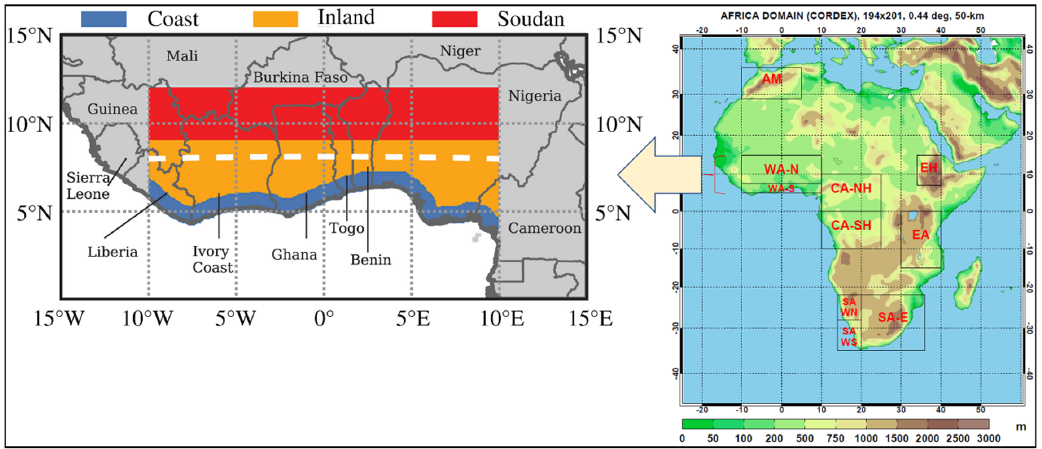
Figure 1. Map of Coordinated Regional climate Downscaling Experiment (CORDEX) West Africa domains (marked WA-N and WA-S) where the analysis was done. Map adapted from https://bit.ly/2BR3qBJ and [25] under the terms of the Creative Commons Attribution 4.0 International license (CC-BY 4.0).